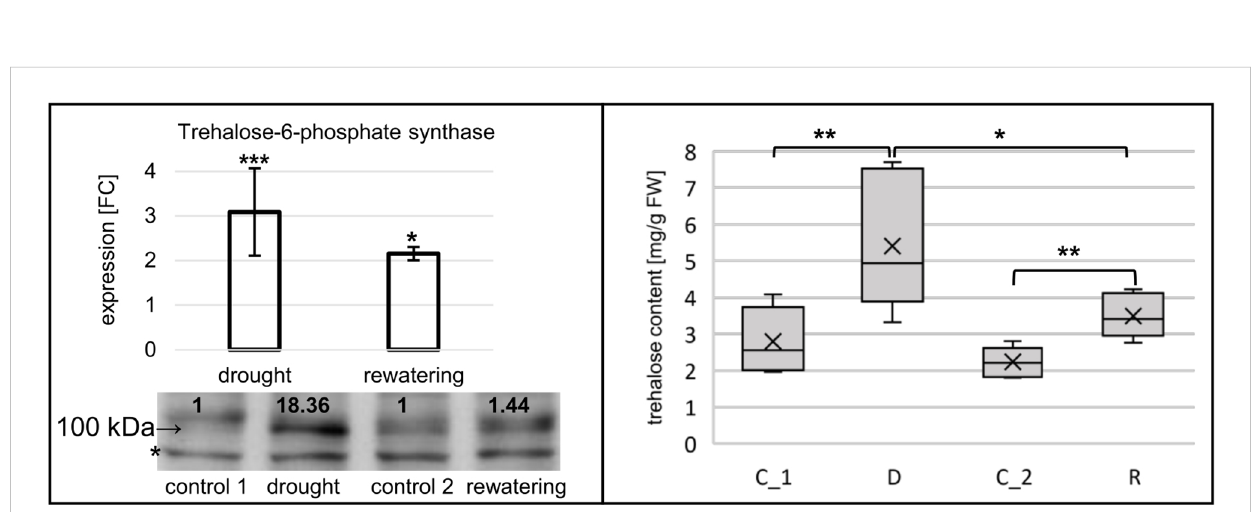
FIGURE 6 Drought induces trehalose synthesis in barley through the expression regulation of TPS . Left panel, the expression of TPS is elevated during drought and rehydration at the level of mRNA, while the protein level is strongly increased only during drought. Target mRNA expression was revealed by RT-qPCR; the result is shown as FC. The numbers below the blot image are the relative intensities of the protein band; control signals were treated as 1. The protein signal was corrected with an unspeci fi c signal (*) as a loading control. In the right panel, trehalose content measurements in drought- and rehydration-stressed barley. Trehalose content increases during drought; the change is quickly reversed by rewatering. The signi fi cance of the mRNA expression changes and trehalose content differences were calculated with two-tailed Student ’ s t -test (***p ≤ 0.001, **p ≤ 0.01, and *p ≤ 0.05).